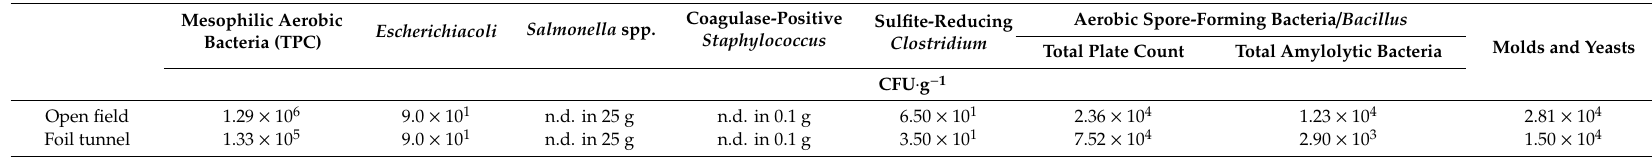
Table 8. Quantitative microbial contamination of fresh herb; TPC—total plate count; n.d.—not detected; CFU—colony-forming unit.